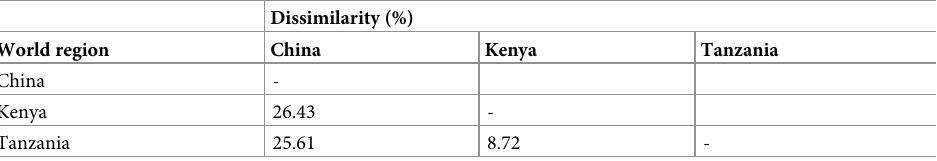
Table 1. Interpopulation beta diversity (%) in the metagenomes of Diaphorina citri from different world regions, as estimated using the Bray Curtis dissimilarity